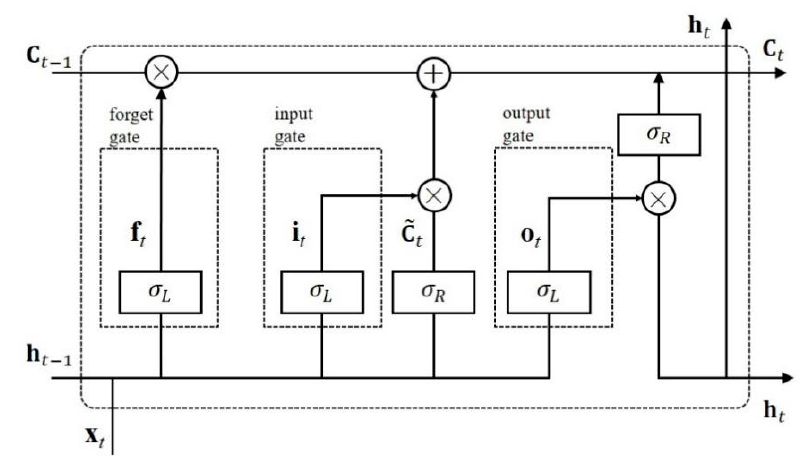
Figure 4. A basic LSTM block. f t , i t and o t are outputs of the forget gate, the input gate and the output gate respectively at time step t . C t − 1 and C t correspond to the cell state of the time t and time t-1 . (cid:101) C t represents the fresh information brought in at time step t .